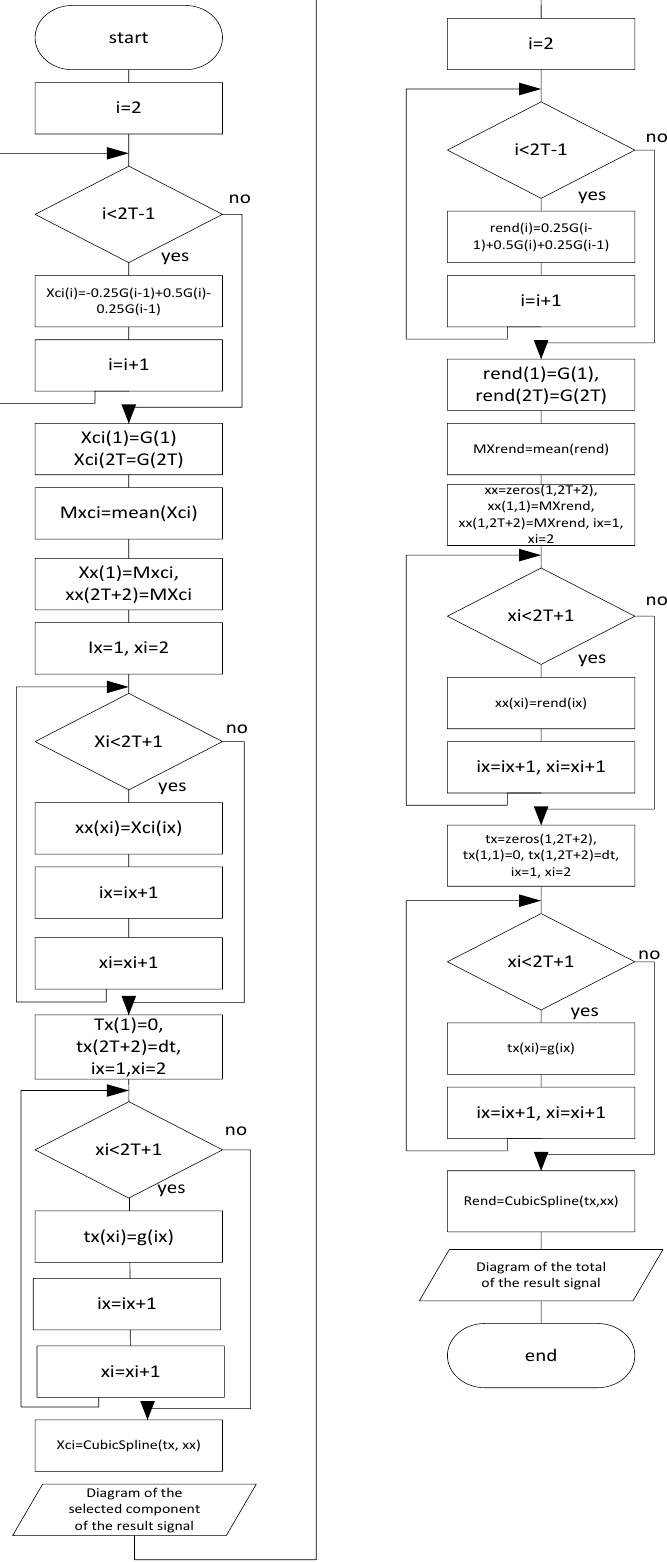
Figure 5. The smoothing algorithm, the selection of the component and the remainder.